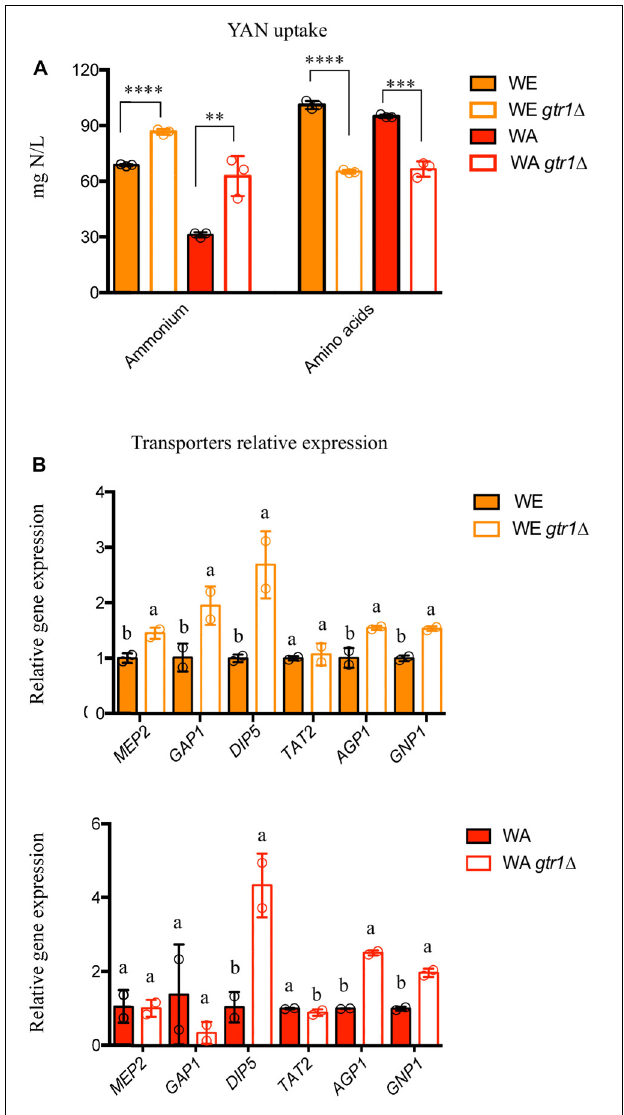
FIGURE 1 | Fermentation performance of the GTR1 null mutants in SM300 medium. (A) Nitrogen consumption for null mutants and wild type strains. Plotted values correspond to the average of three biological replicates (dots), with their standard error represented by bars (mean ± SE). The asterisks represent different levels of significance between the phenotypes of null mutants and wild type strains ( t -test; ∗∗ p < 0.01, ∗∗∗ p < 0.001, and ∗∗∗∗ p < 0.0001). (B) Relative gene expression at 6 h of fermentation for nitrogen transporters in the WE (top panel) and WA (bottom panel) genetic backgrounds. Expression levels were normalized using three housekeeping genes. Plotted values correspond to the average of two biological replicates (dots), with their standard error represented by bars (mean ± SE). Different letters represent significant statistical difference between the null mutants and wild type strains (Mood test with p < 0.05). WE: Wine/European; WA: West African.